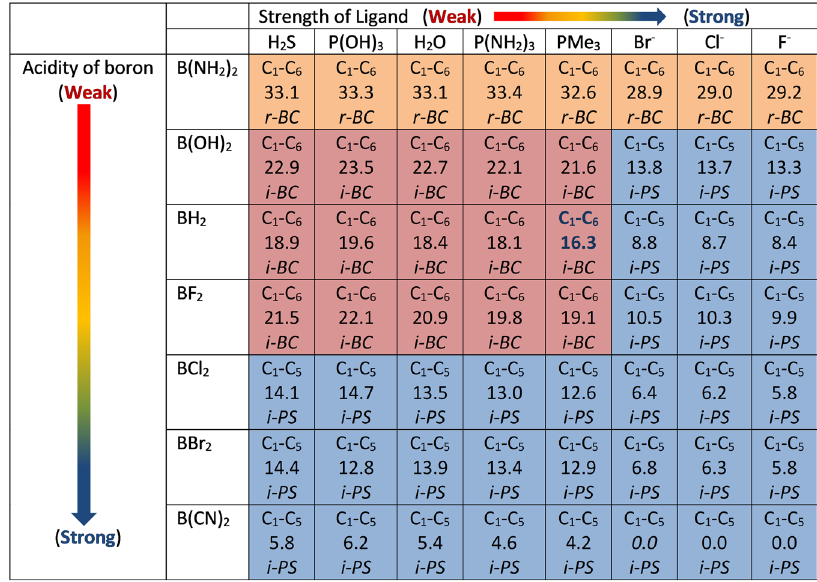
Fig. 12 Comparative study of showing the mode of cyclization and the activation energy as a function of electrophilicity of boryl groups and the strength of ligand on Au(I). Calculations were performed at the B3LYP/LANL2DZ level, and the activation energy is expressed in kcal/mol. The terms i- BC , i- PS , and r- BC denote ionic-Bergman cyclization, ionic Schreiner – Pascal cyclization, and radical Bergman cyclization, respectively. The C 1 – C 6 and C 1 – C 5 represent 6-endo and 5-endo modes of cyclizations,